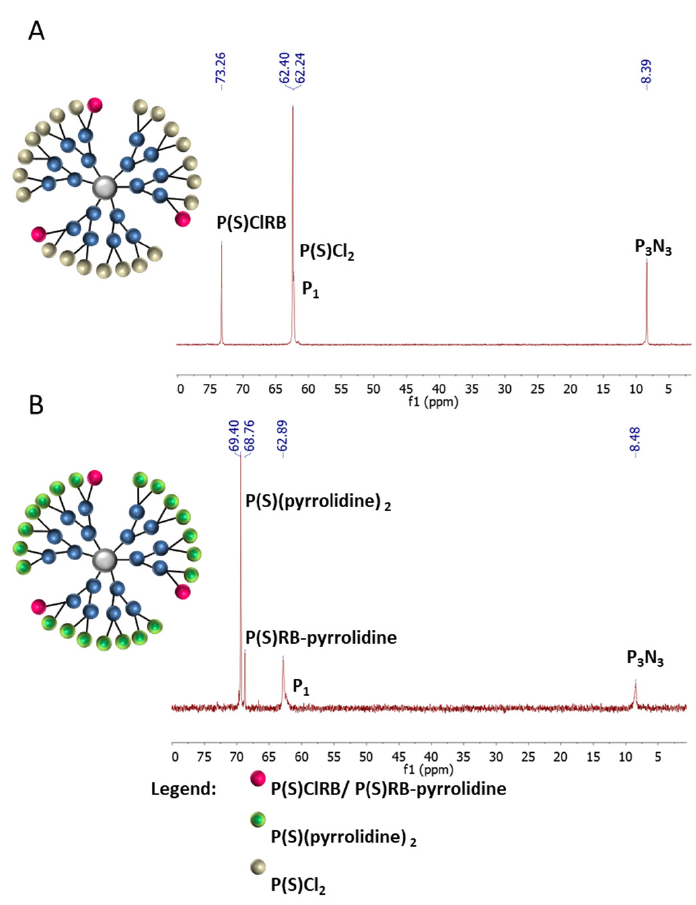
Figure 4. 31 P NMR spectra for: ( A ) G2–3RB (THF-d8; ppm), ( B ) G2–3RB–21 pyrrolidine (G2-3RB-pyrro) (CDCl 3 ; ppm).